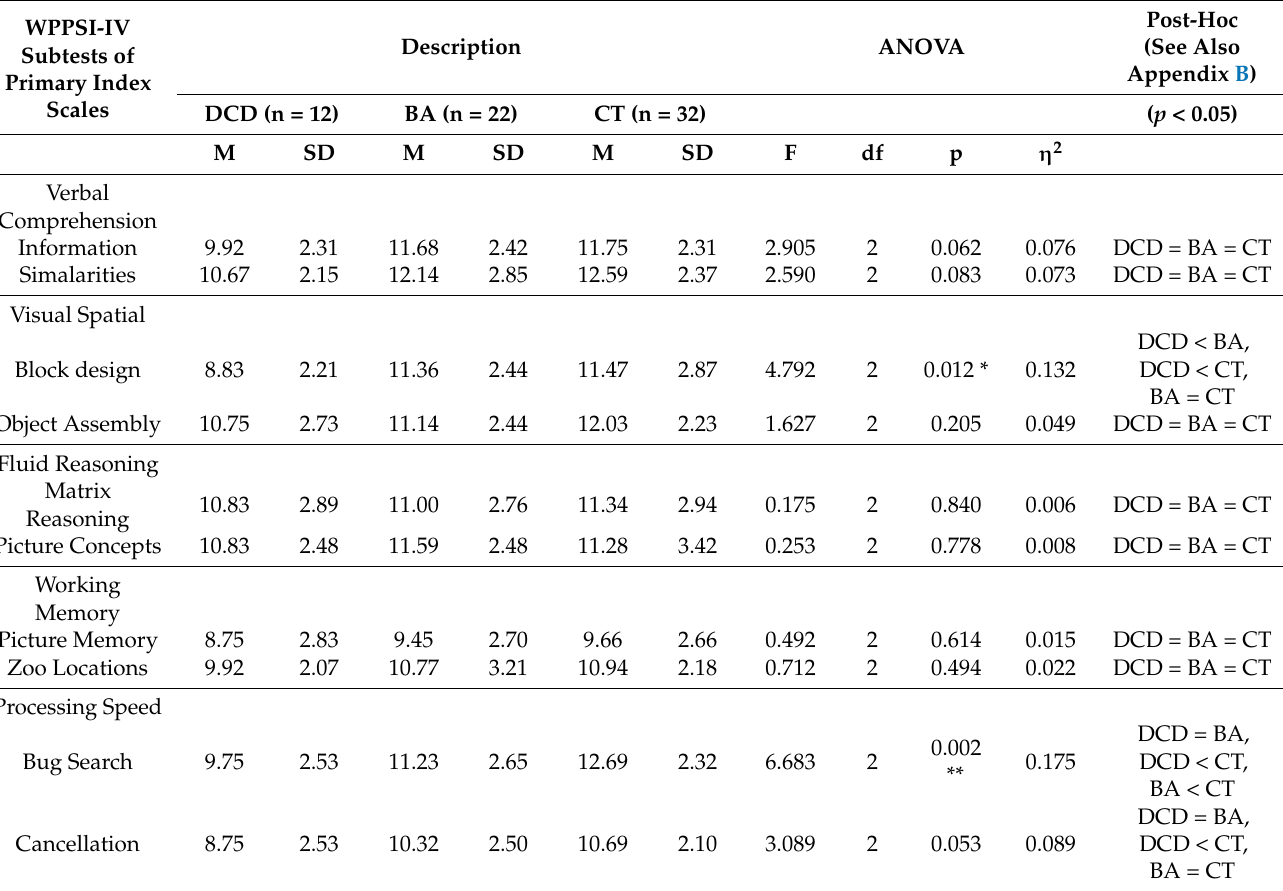
Table 3. Descriptive statistics and characteristic values of the one-factor ANOVA for the WPPSI-IV (IQ) subtests (scaled scores).